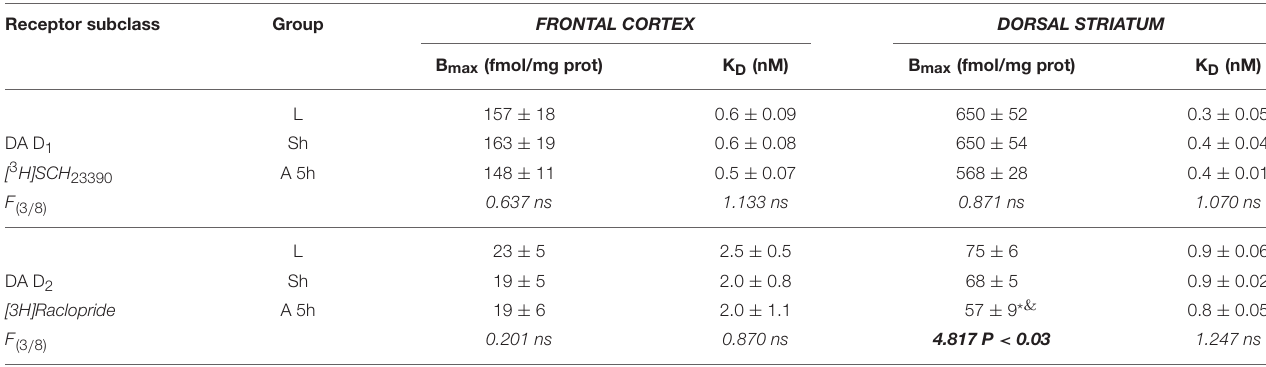
TABLE 8 | The effect of repetitive anodal tDCS (A) of the right prefrontal cortex on the density B max and affinity K D of dopamine D 1 and D 2 receptors IN THE FRONTAL CORTEX and DORSAL STRIATUM of rat. Receptor